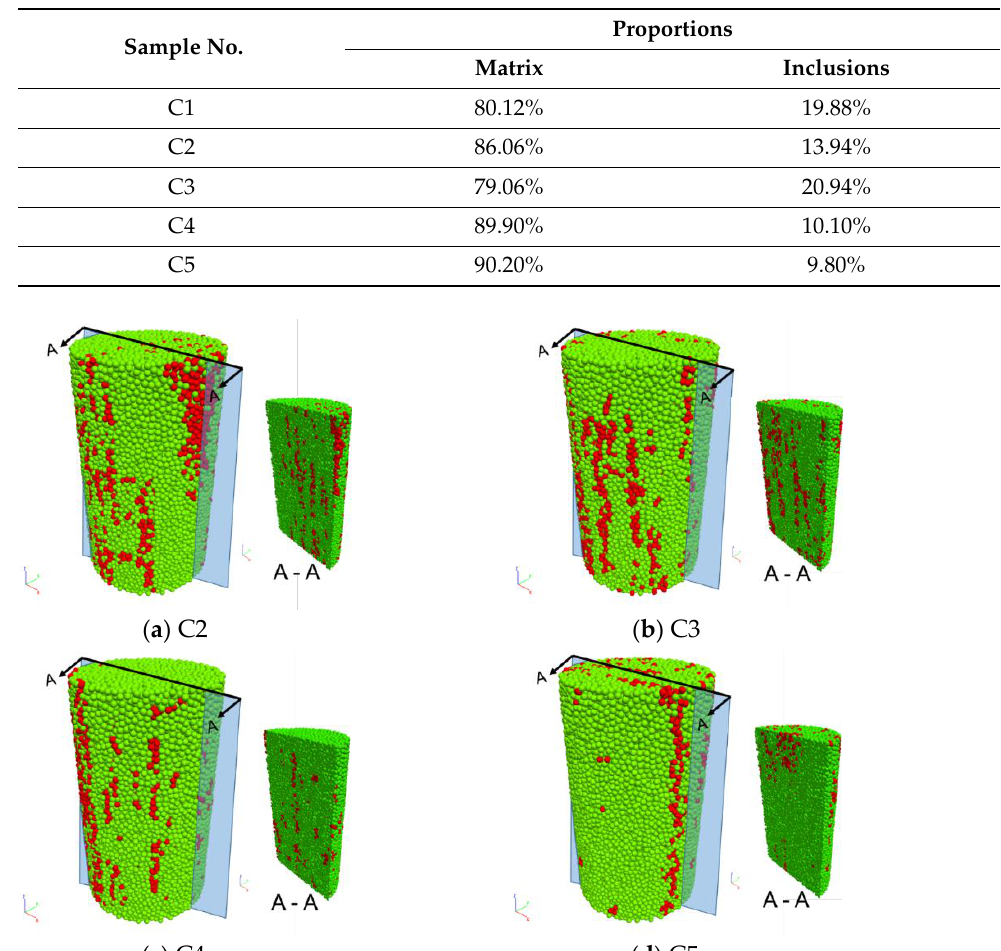
Figure 3. Reconstructed particle-based numerical models of coal samples (green: coal matrix, red: inclusions).